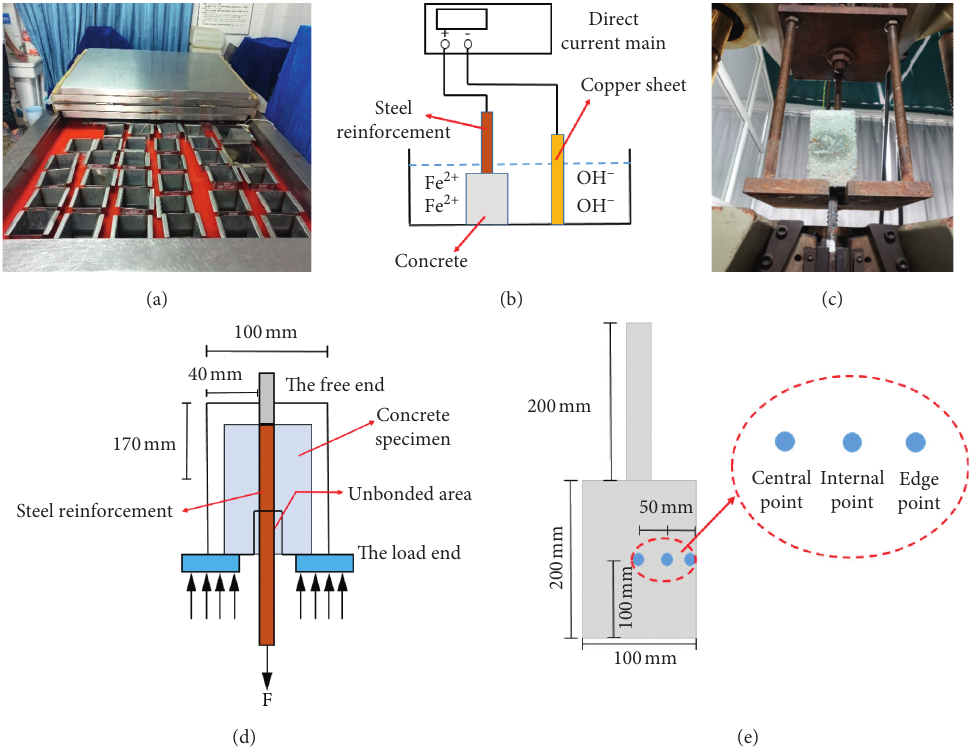
Figure 2: Flow diagram of the experiment. (a) Freeze-thaw test. (b) Accelerated steel corrosion test. (c) Pull-out test loading process. (d) Schematic diagram of the steel reinforcement pull-out test. (e) Samples and points for porosity measurement